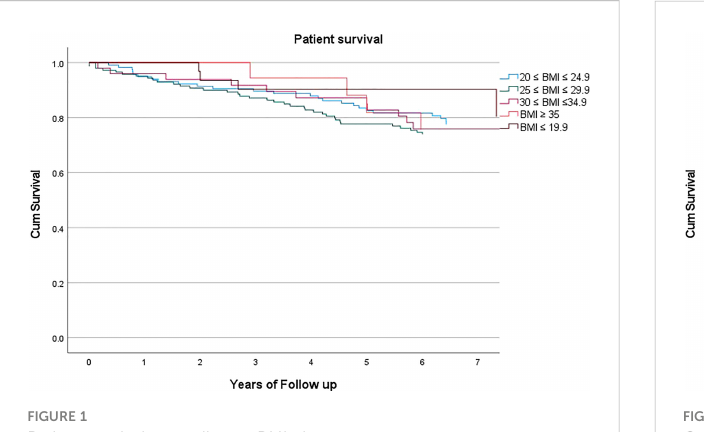
FIGURE 1 Patient survival according to BMI class.